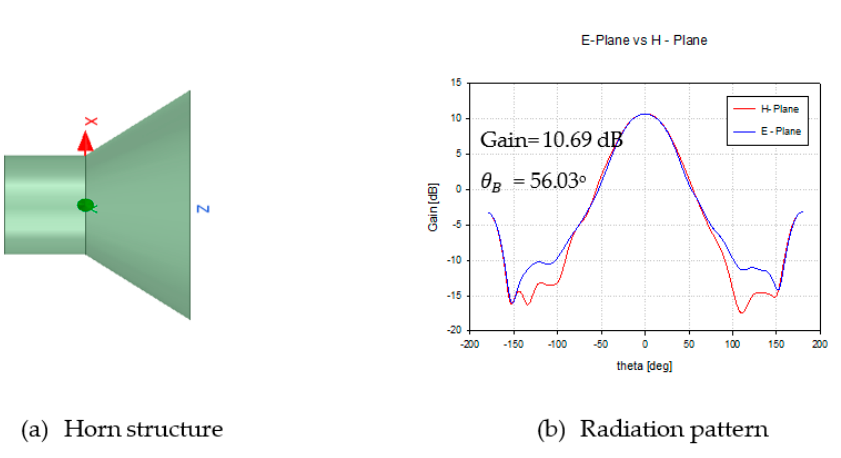
Figure 12. Performance of horn antenna as a feed radiator. Figure 12 . Performance of horn antenna as a feed radiator .